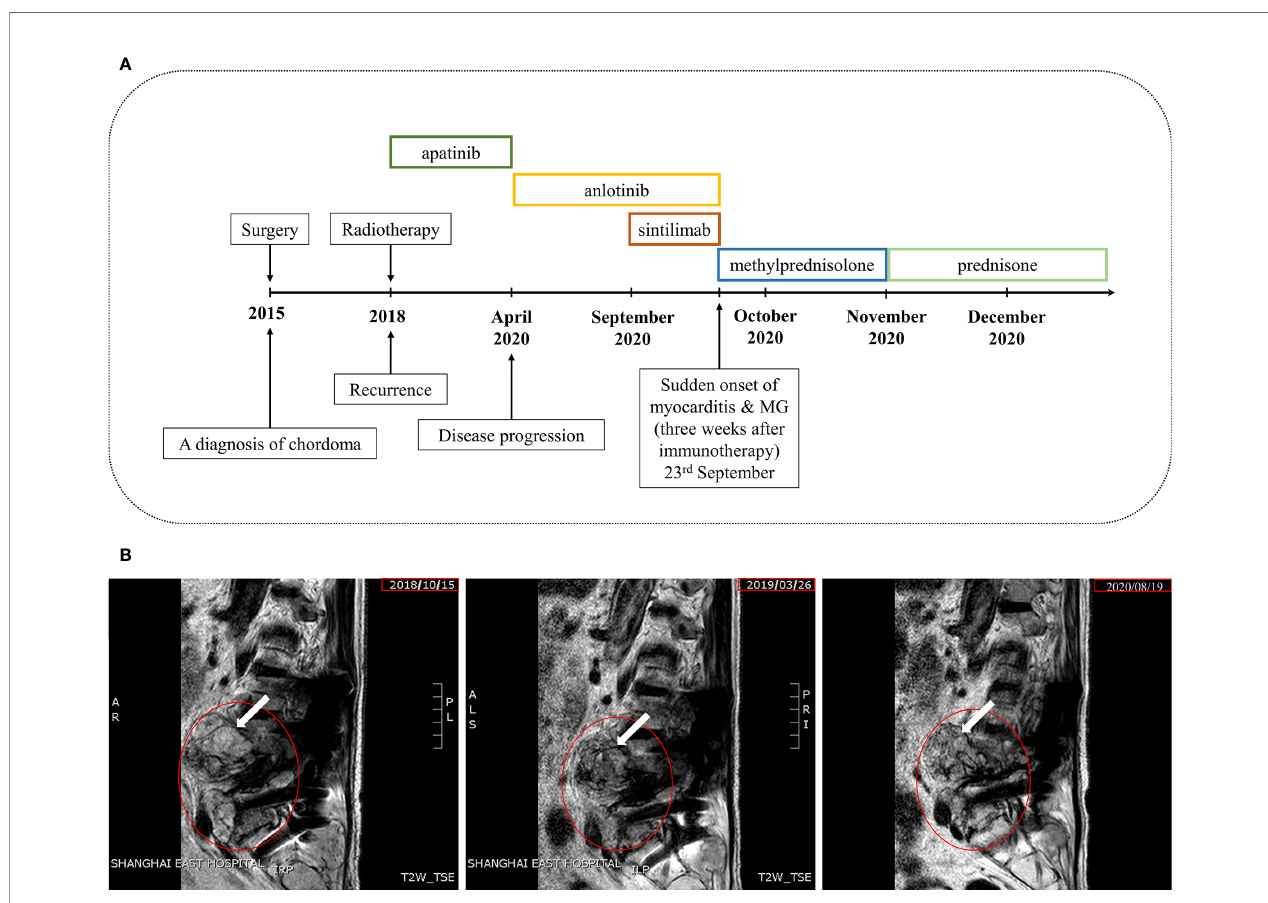
FIGURE 1 | Case presentation. (A) Timeline of disease diagnosis and treatment. (B) Magnetic resonance imaging (MRI) from 2018 to 2020 (from left to right) in T2WI. The red circle indicates the damaged lesion and the white arrow indicates the tumor